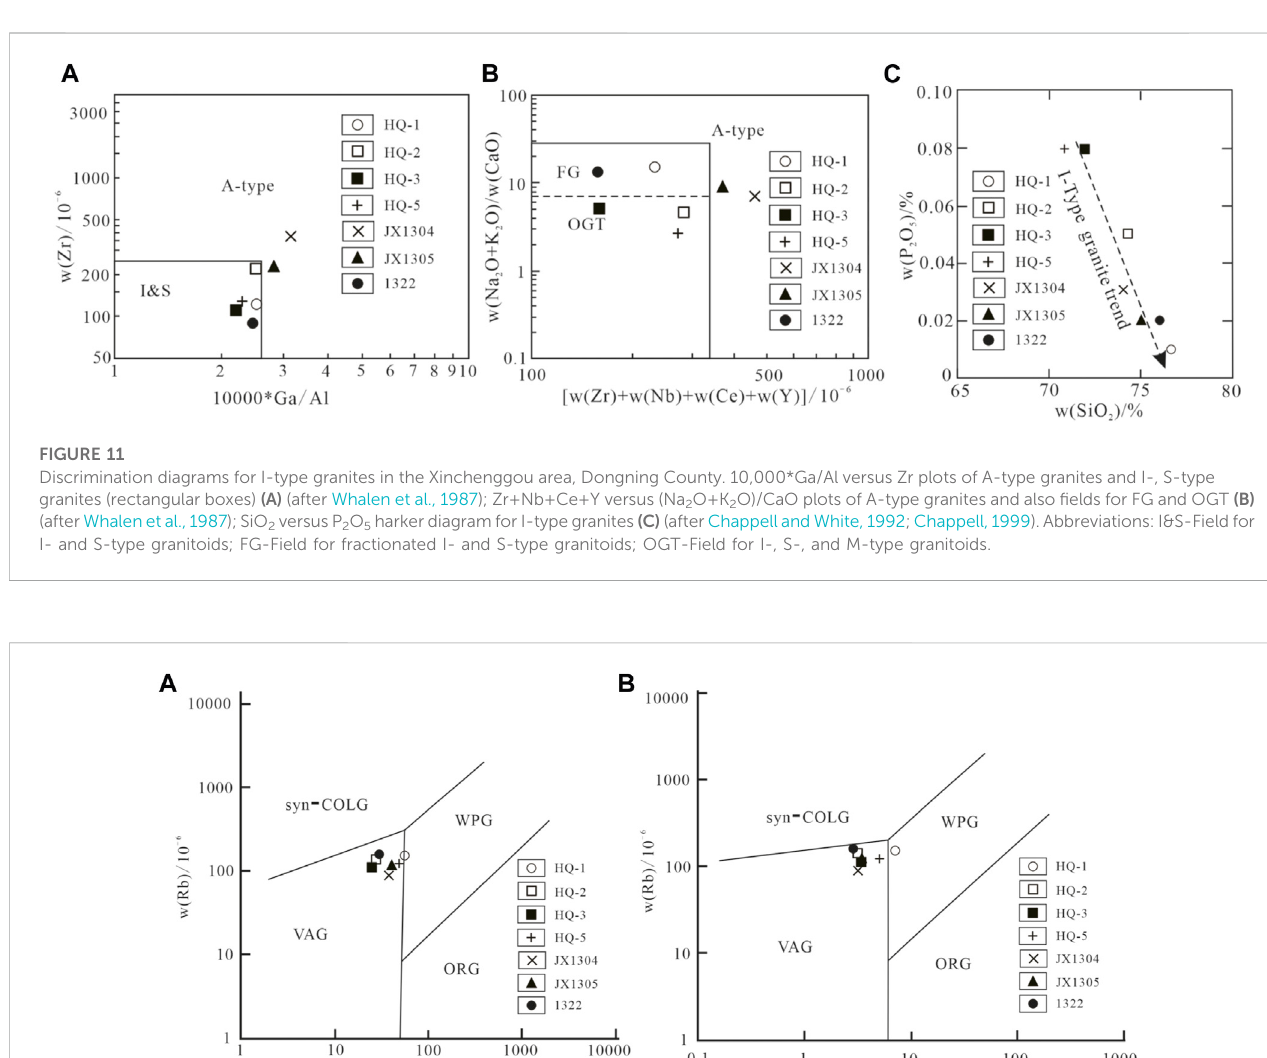
Frontiers in Earth